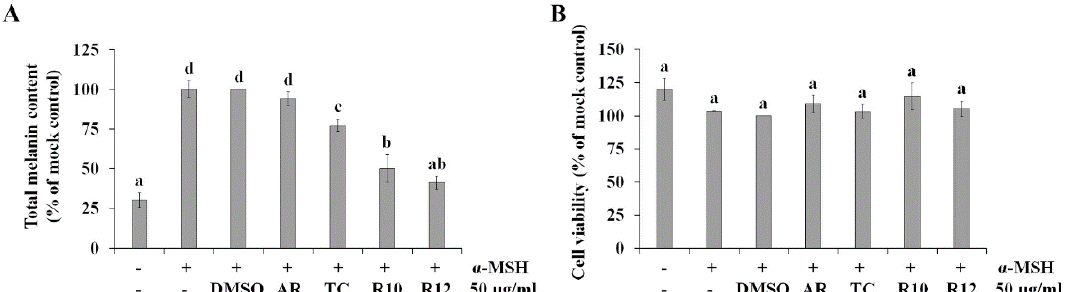
Figure 5. Anti-melanogenic activity of PAP1 -overexpressing ginseng hairy root extracts. The effect of PAP1 -overexpressing ginseng hairy root extracts on melanin production ( A ) and cell viability ( B ) was analyzed in α -MSH-stimulated B16F10 cells. The values represent the means of three replicates ± SE. Values with the same letter were deemed not significantly different by Duncan’s multiple range tests. Transgenic lines: R10 and R12; Transgenic control: TC; Ginseng adventitious root: AR.